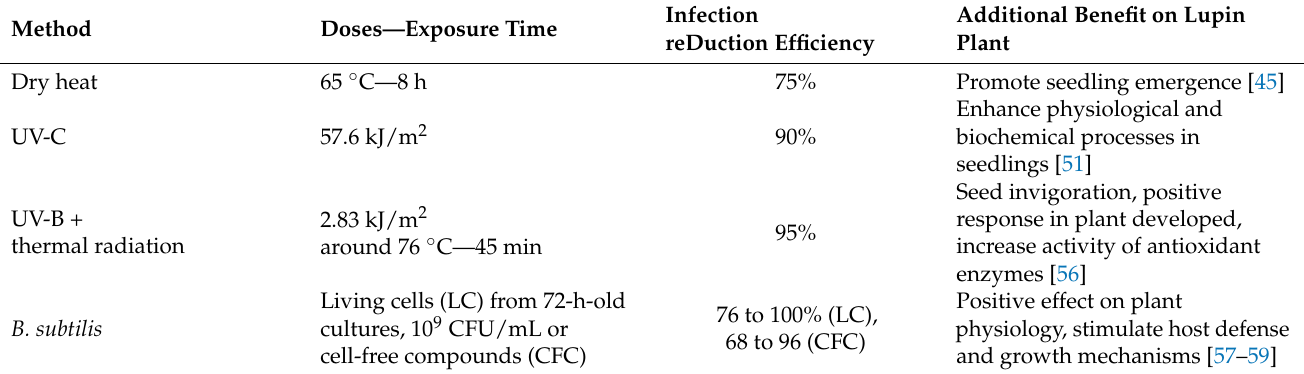
Table 3. Alternative methods for the management of Andean lupin anthracnose infected